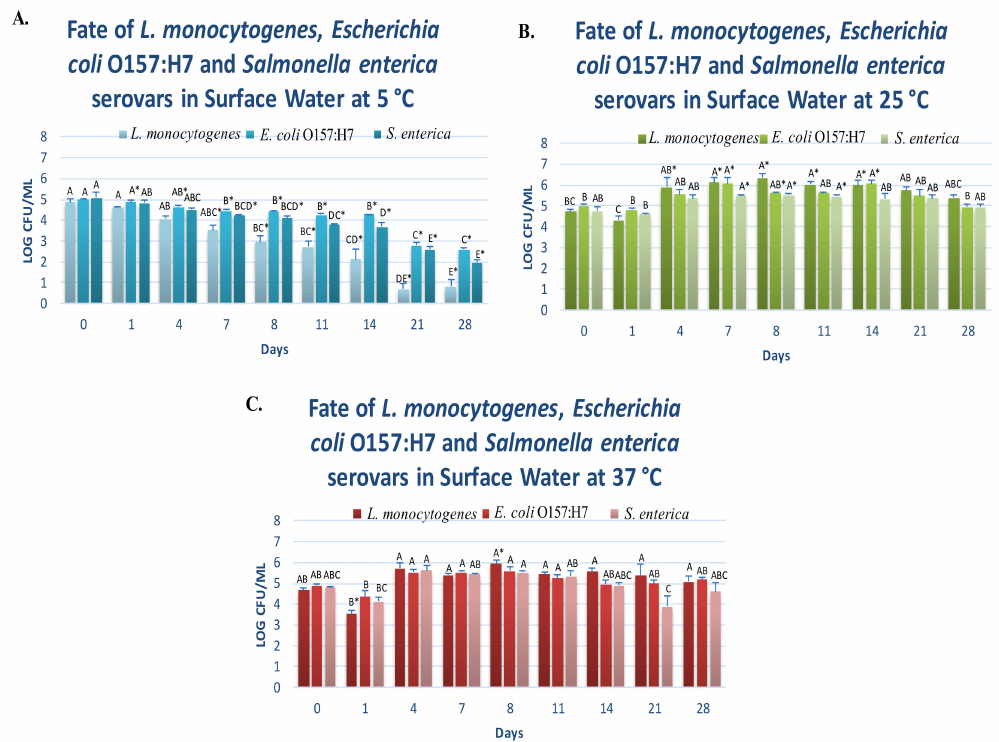
Figure 2. Fate and survival of four-strain cocktail of Listeria monocytogenes (ATCC ® numbers 51772, 51779, BAA-2657, and 13932), six-strain cocktail of E. coli O157:H7 (ATCC ® numbers BAA-460, 43888, 43894, 35150, 43889, 43890), and five-strain cocktail of non-typhoidal Salmonella enterica serovars (ATCC ® numbers 13076, 8387, 6962, 9270, 14028) in autoclaved Cumberland river water for 0, 1, 4, 7, 8, 11, 14, 21, and 28 days at 5, 25, and 37 ◦ C. In each graph, and for each pathogen separately, columns of each time interval followed by di ff erent uppercase letters are representing log CFU / mL values that are statistically ( p < 0.05) di ff erent (Tukey-adjusted ANOVA). Uppercase letters followed by * sign are statistically ( p < 0.05) di ff erent than the untreated control (Dunnett’s-adjusted ANOVA). ( A ) Survival of three pathogens at 5 ◦ C; ( B ) Survival of three pathogens at 25 ◦ C; ( C ) Survival of three pathogens at 37 ◦